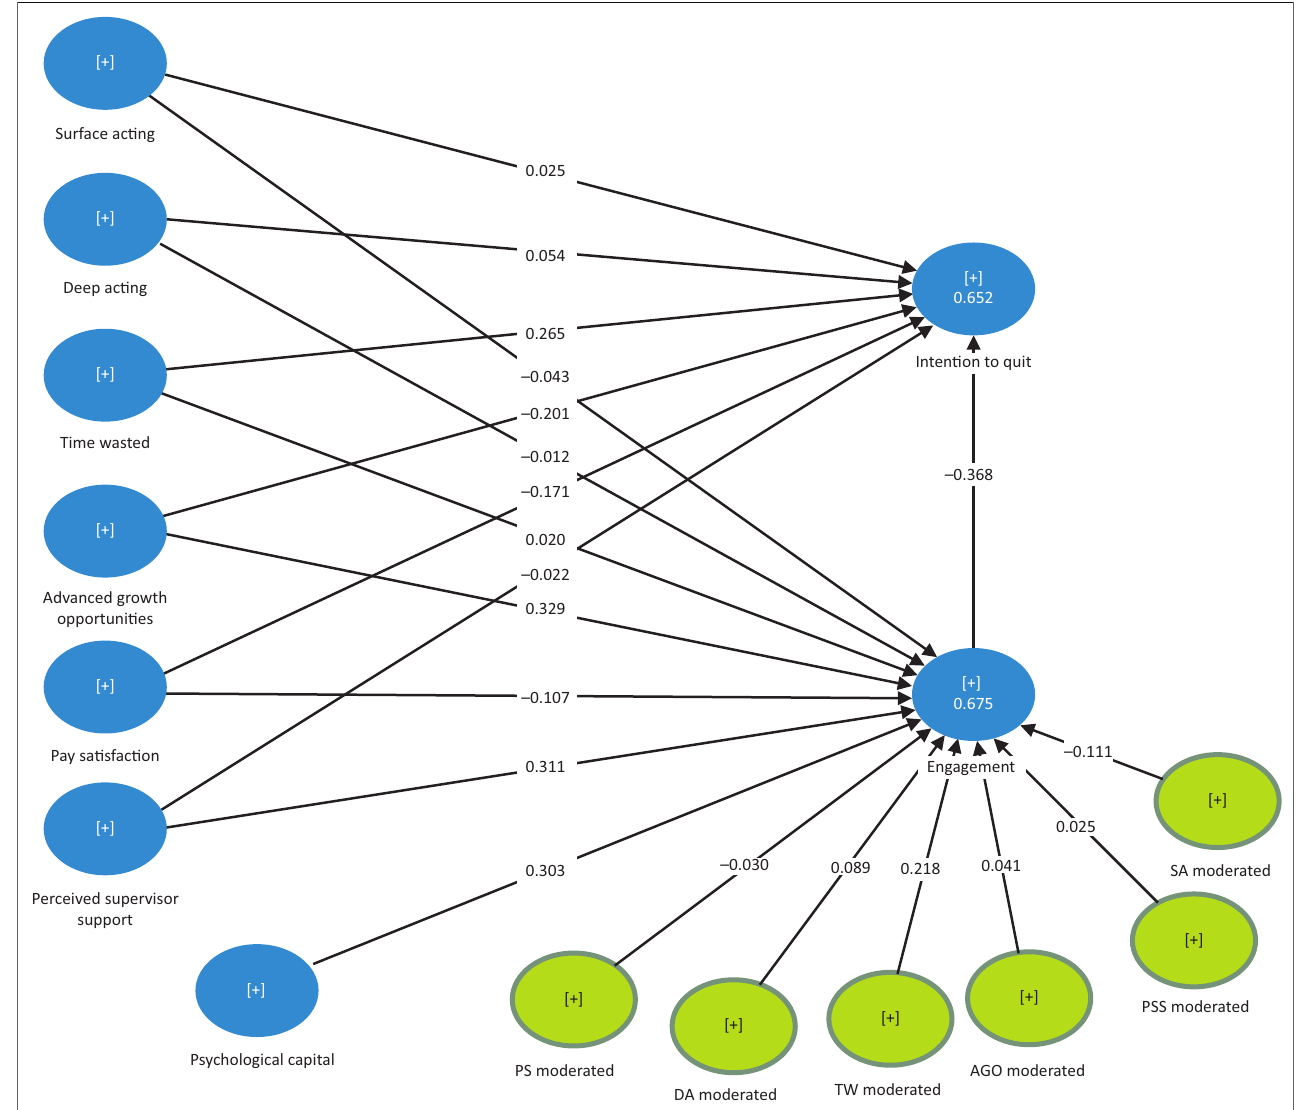
FIGURE 1: Inner (structural) model with path